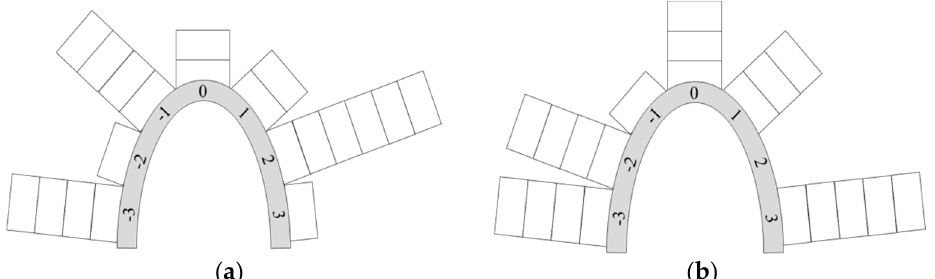
Figure 2. Distribution of participants along the seven categories discussing statement no. 1 ( a ) and statement no. 2 ( b ). Each rectangle represents one participant. Patterns as emerged during the Edinburgh exercise.